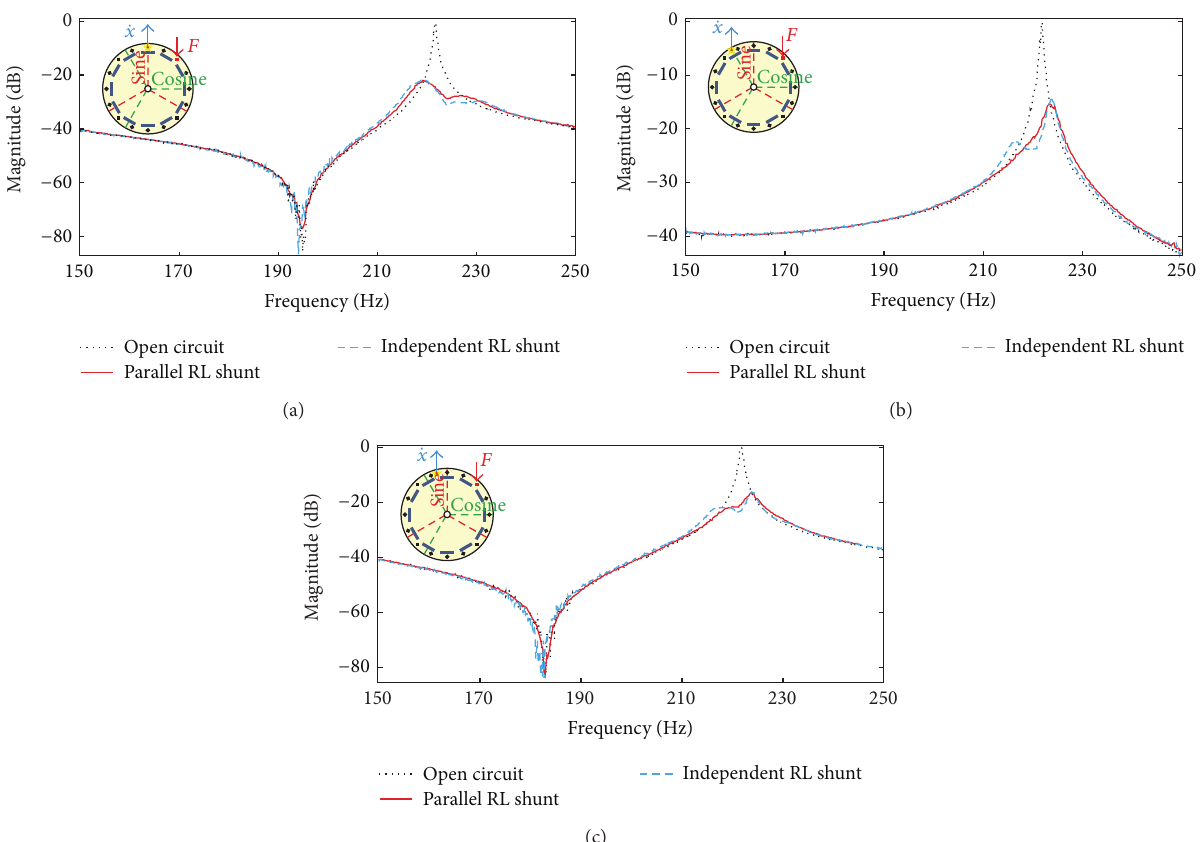
Figure 7: Disk experiment: comparison between the independent shunt and parallel shunt for the first mode with 𝑛 = 3 nodal diameters. The dotted lines correspond to the original system, with a natural damping of 0.5%. (a) ̇𝑥 is measured at the point where the sine mode is maximized.(b) ̇𝑥 ismeasuredatthepointwherethecosinemodeismaximized.(c) ̇𝑥 ismeasuredinthemidway,wherebothmodescontribute to the response.